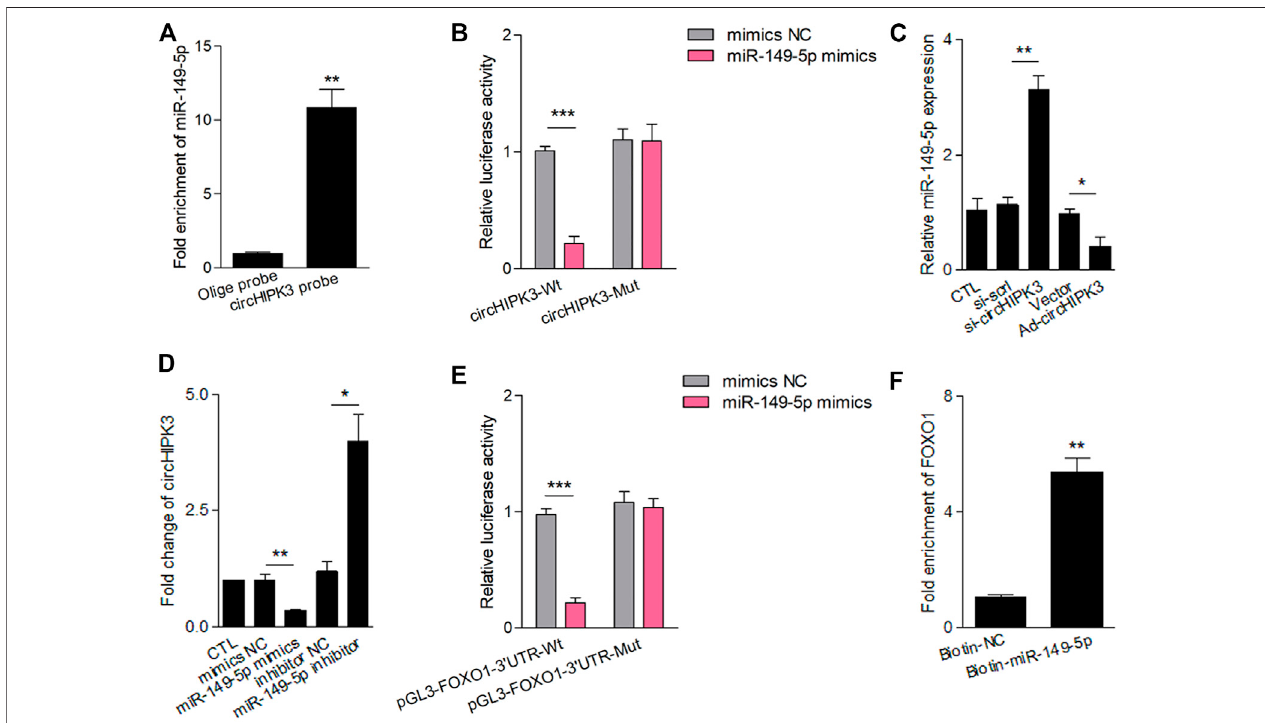
FIGURE 2 | CircHIPK3 interacted with miR-149-5p, and FOXO1 was a target of miR-149-5p. (A) MiR-149-5p was pulled down and enriched with biotinylated circHIPK3probe (n (cid:1) 3; ** p < 0.01). (B) The relative luciferase activity ofcircHIPK3wasmarkedly suppressed when co-transfected withwild circHIPK3and miR-149-5p mimics compared with the control reporter or mutated luciferase reporter (n (cid:1) 3; *** p < 0.001). (C) qRT – PCR detection showed that the expression of miR-149-5p was signi fi cantlyincreased/reducedinthecircHIPK3knockdown/overexpressiongroupcomparedwitheachcontrolgroup(n (cid:1) 3;* p < 0.05,** p < 0.01). (D) Thelevelof circHIPK3 could be signi fi cantly reduced/enhanced by miR-149-5p mimics/inhibitor compared with each control group (n (cid:1) 3; * p < 0.05, ** p < 0.01). (E) Luciferase reporter assays showed that the luciferase activity of FOXO1 wild-type reporter was signi fi cantly reduced when transfected with miR-149-5p mimics compared with control reporter or mutated luciferase reporter (n (cid:1) 3; *** p < 0.001). (F) A signi fi cant enrichment of FOXO1 mRNA in the pulled down sediments of 3 ′ end biotin-labeled miR-149-5p. (n (cid:1) 3; ** p < 0.01). Results are expressed as the mean ± S.E.M. CTL (cid:1) PBS control group. si-scrl (cid:1) scramble siRNA. NC (cid:1) negative